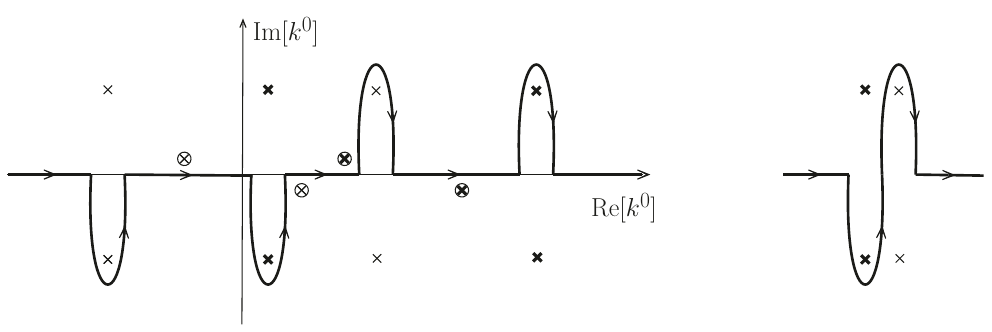
Figure 1 . Lee-Wick integration path.